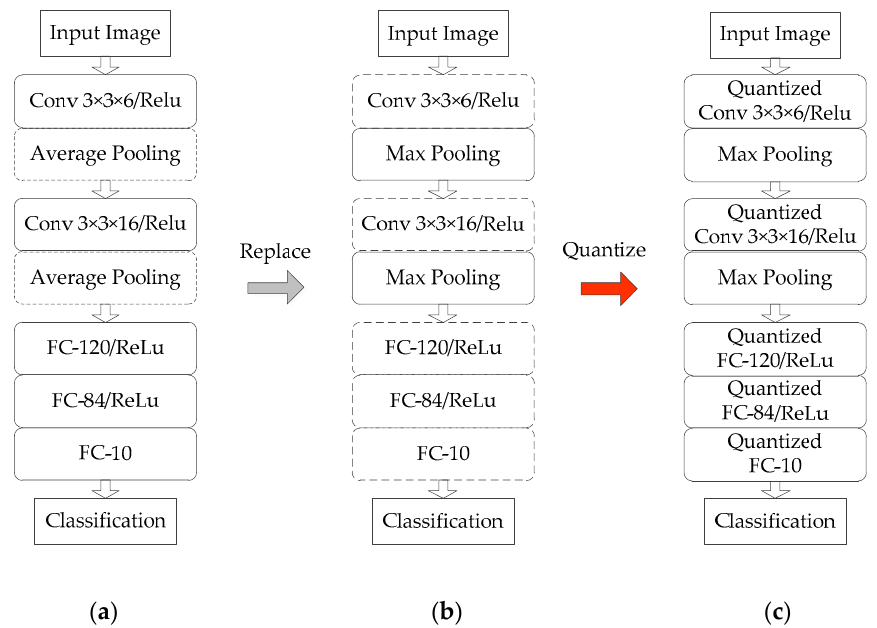
Figure 2. Frameworks of the fundamental network ( a ) modified network ( b ) and quantized network ( c ).